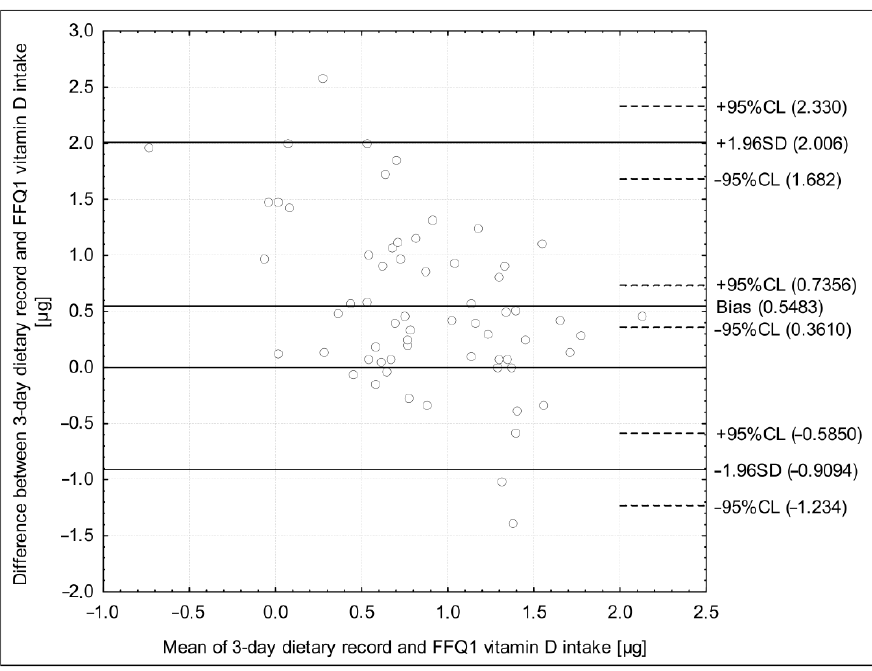
Figure 2. The Bland-Altman plot in the assessment of validity of the Cro-VIDEO-FFQ questionnaire (Bland-Altman index of 4.8%, due to 60 out of 63 individuals within the limit of agreement). Cro-VIDEO-FFQ1—the food frequency questionnaire to assess vitamin D intake in the first stage.